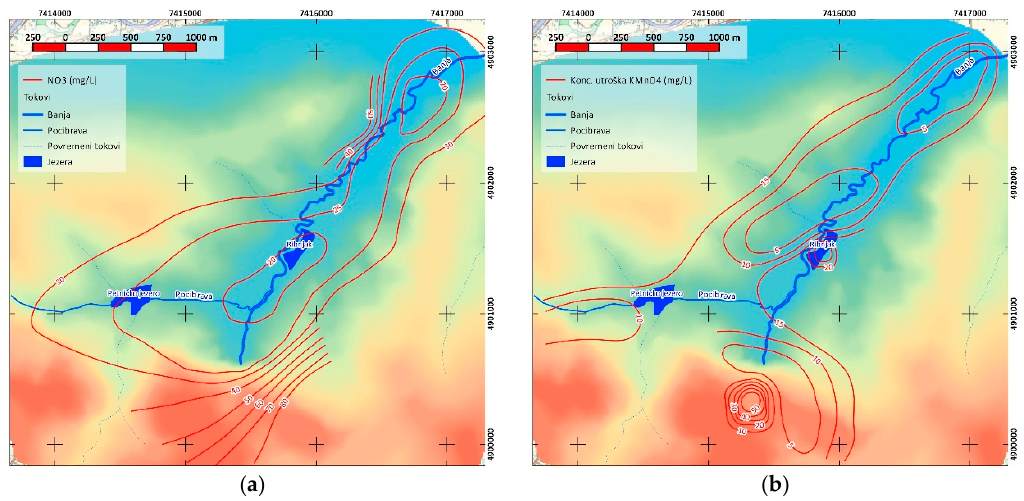
Figure 6. ( a ) Isolines of nitrate concentration; ( b ) isolines of KMnO 4